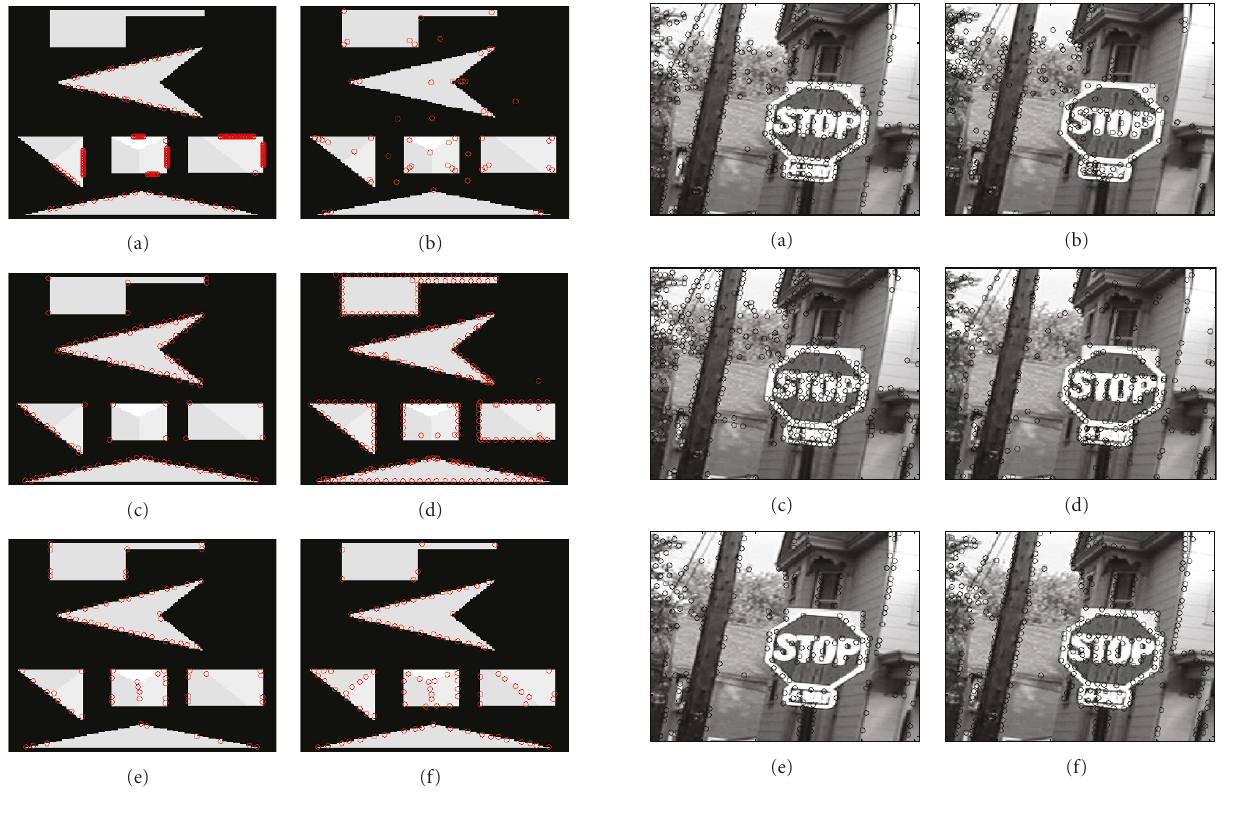
Figure 6: Feature points detected by (a) Harris method (b) Lowe’s method, (c) Tomasi’s method, (d) Loupias’s technique, (e) Yeh’s algorithm, and (f) proposed